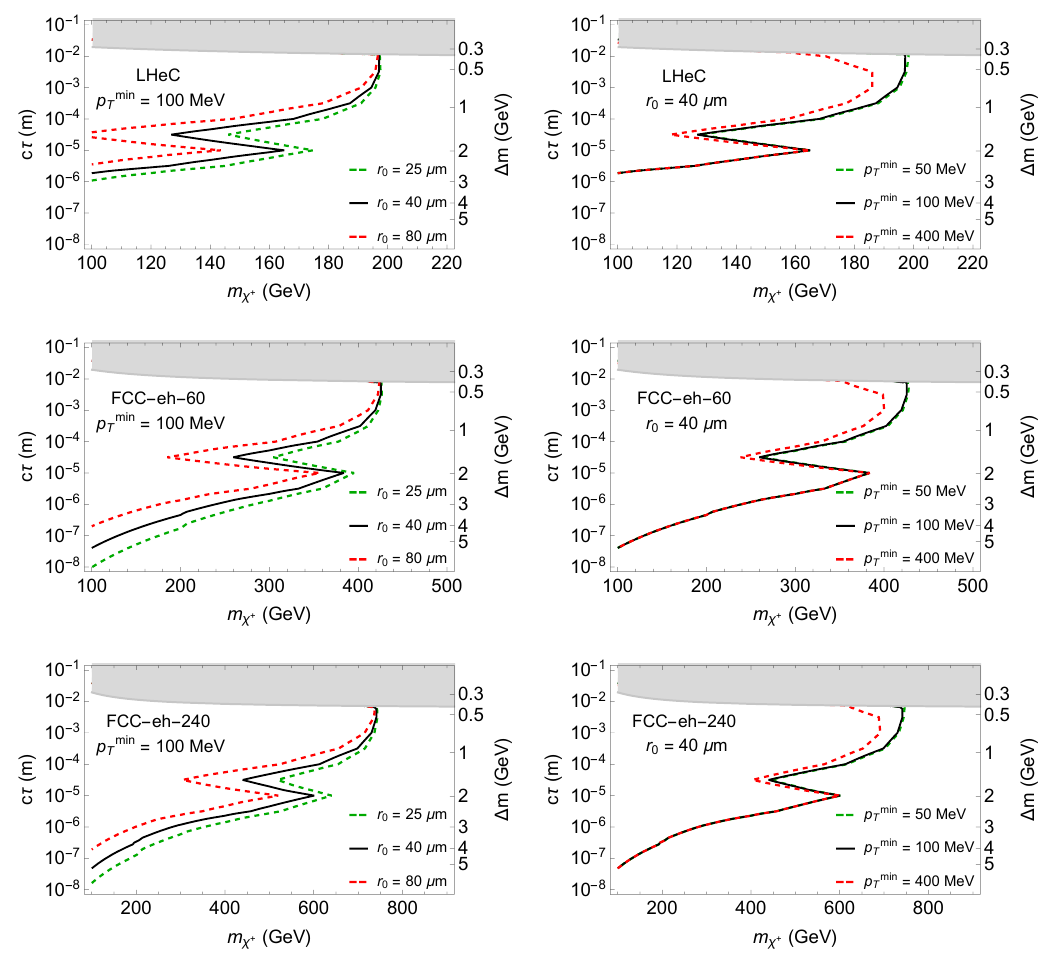
min Figure 10 . Reach dependence on r for the Higgsino search requiring a single tagged 0 and p T LLP decay. All plots assume 1 ab (cid:0) 1 of data, (cid:22) > 0, and the most optimistic estimate for event yield given hadronization and displaced jet reconstruction